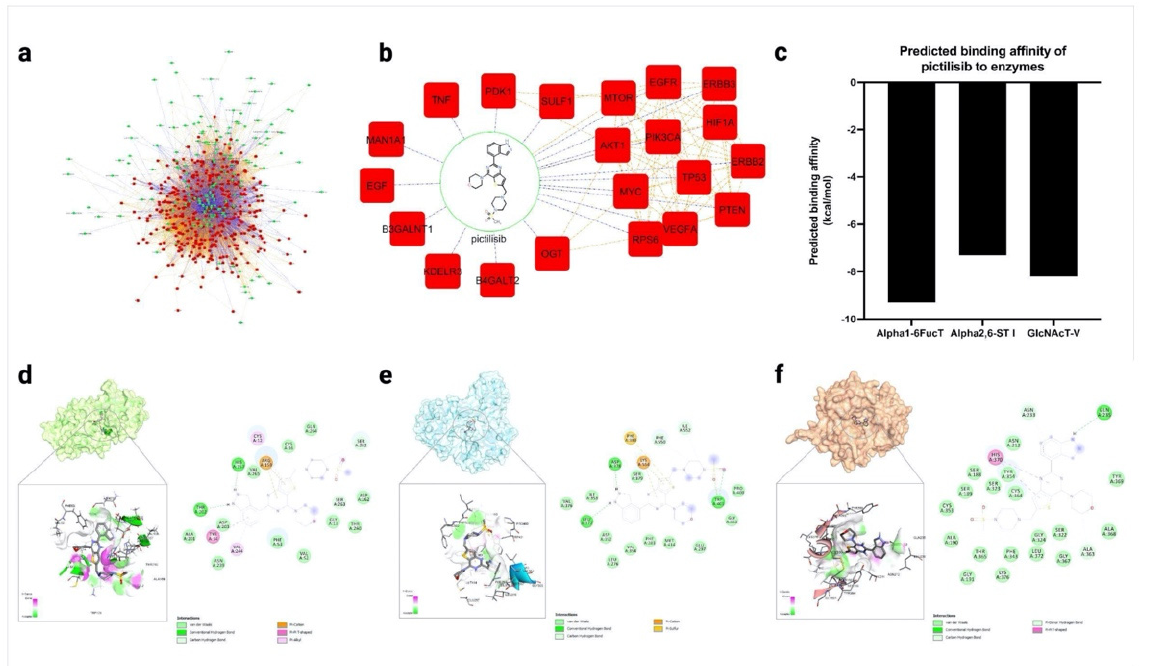
Figure 6. Pictilisib was predicted to interact and inhibit several glycosylation-related genes through network pharmacology and in silico binding approach. ( a ) Drug–gene interaction network of selected glycosylation targeting compounds; ( b ) Sub-network of pictilisib drug–gene interactions; ( c ) The binding affinity of pictilisib against Alpha1-6FucT, GlcNAcT-V, and Alpha2,6-ST I; ( d – f ) Docking conformation and residue interactions of pictilisib with Alpha1-6FucT, GlcNAcT-V, and Alpha2,6-ST I, respectively.